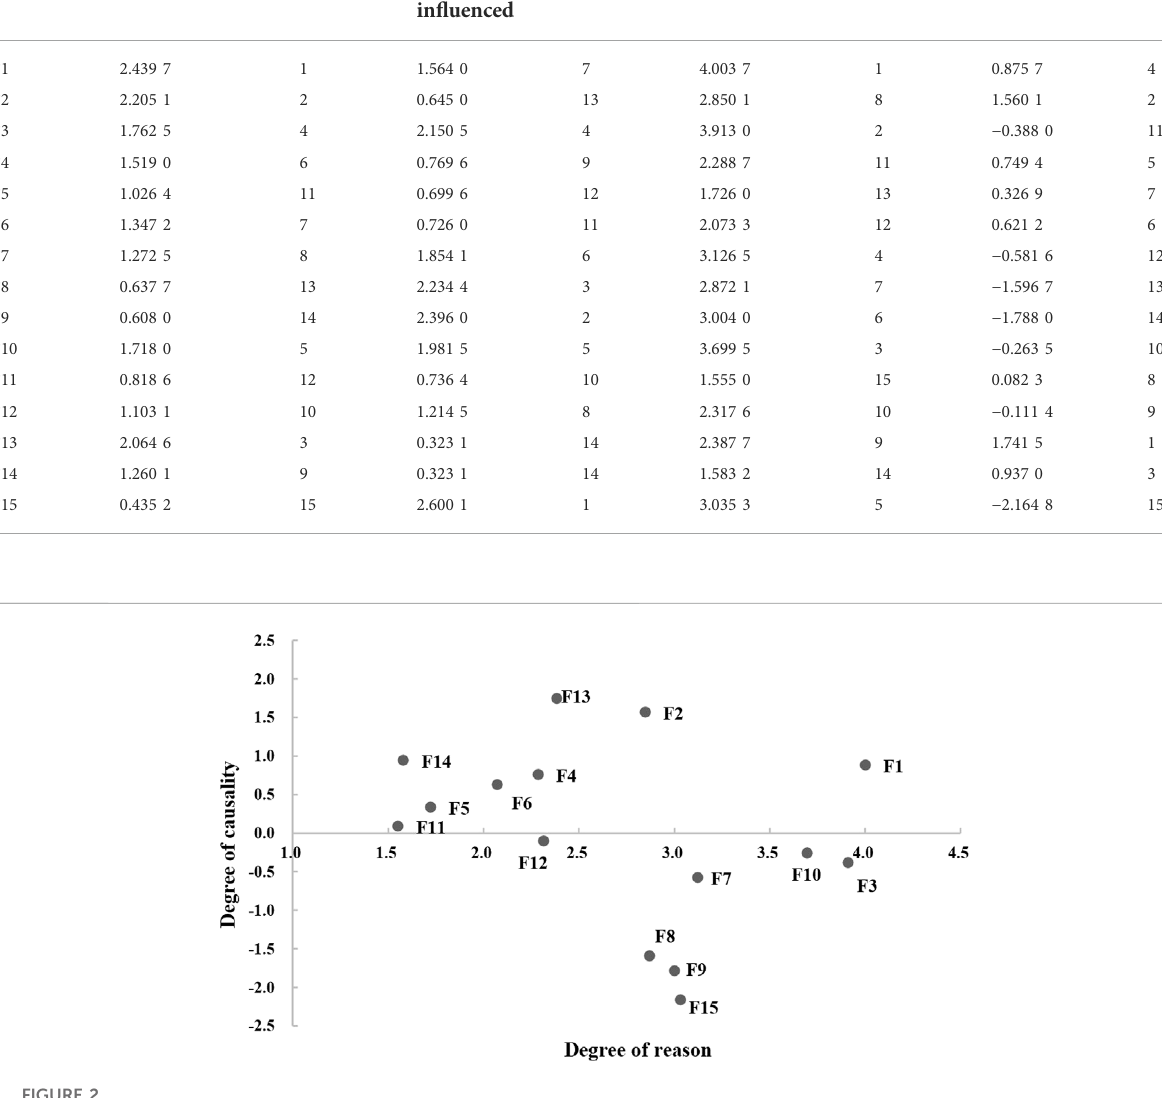
TABLE 5 Analytical indicators of the integrated in fl uence matrix.